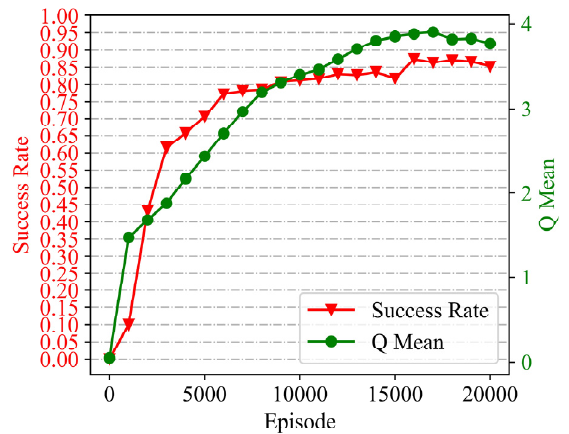
Figure 5. The training map collection.